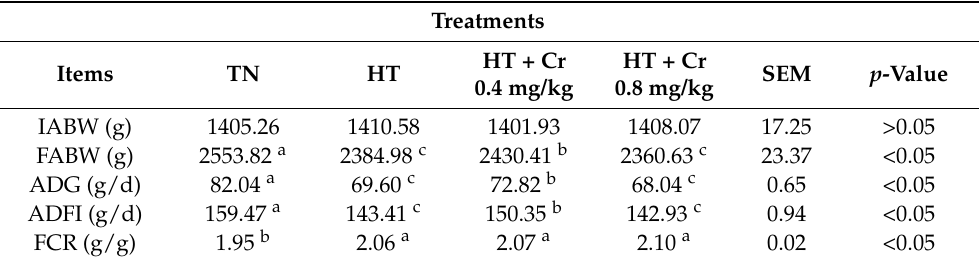
Table 5. Effect of chromium supplementation on performance of heat-stressed